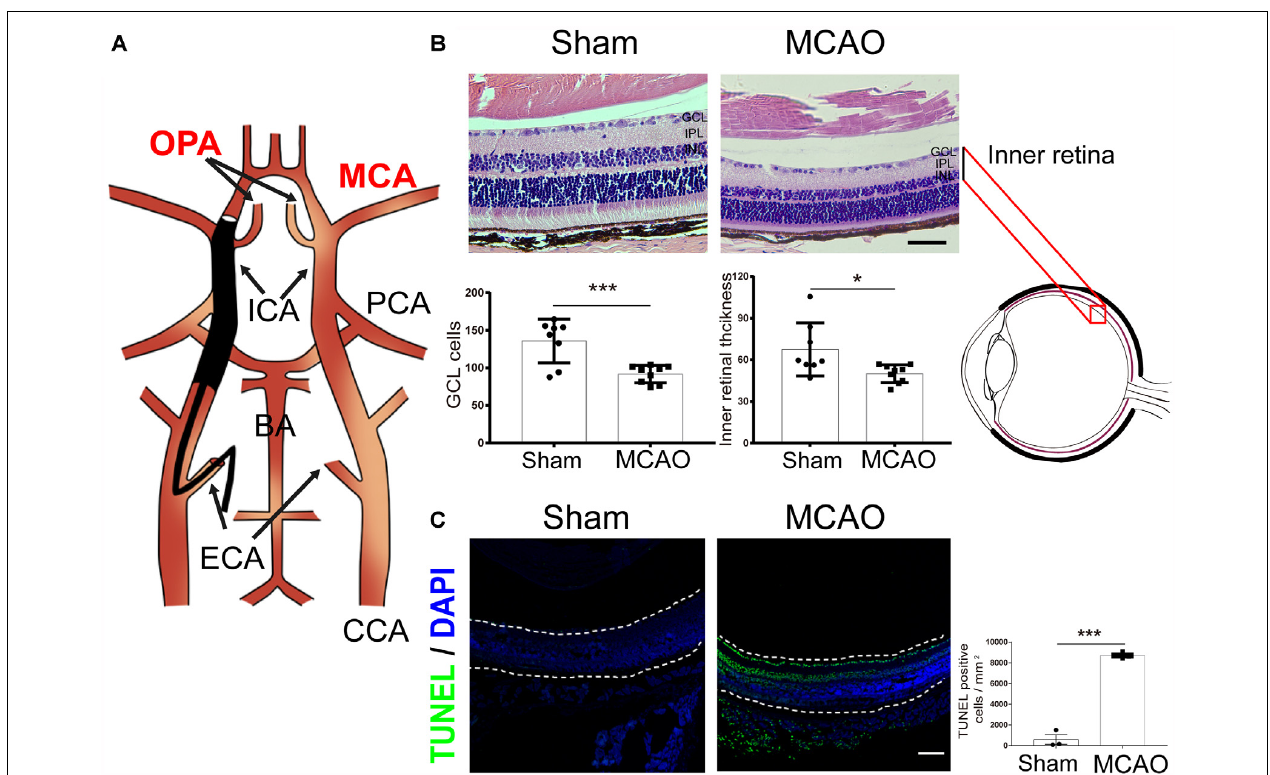
FIGURE 2 | Ischemic stroke induces retinal injury in diabetic mice. (A) Schematic diagram of MCAO model blocking the OPA. Monofilament is inserted into the right MCA to block blood flow, thereby blocking the OPA at the same time. (B) Top, representative H&E staining in retina post-MCAO. Scale bar, 50 µ m. Bottom, bar graphs showing the GCL cell count and the inner retinal thickness in the sham ( n = 7) and MCAO group ( n = 9). (C) Left, representative images showing TUNEL staining in retina post-MCAO. The retina is indicated between the dotted lines. Green, TUNEL positive cell; Blue, DAPI (magnification, 100 × ; scale bar, 100 µ m). Right, bar graphs showing the TUNEL positive cells density at GCL in the sham ( n = 3) and MCAO groups ( n = 4). Sham and MCAO mice were administered with vehicle pretreatment. OPA, ophthalmic artery; MCA, middle cerebral artery; PCA, posterior cerebral artery; ICA, internal carotid artery; BA, basilar artery; ECA, external carotid artery; CCA, common carotid artery; GCL, ganglion cell layer; IPL, inner plexiform layer; INL, inner nuclear layer. * P < 0.05, *** P <